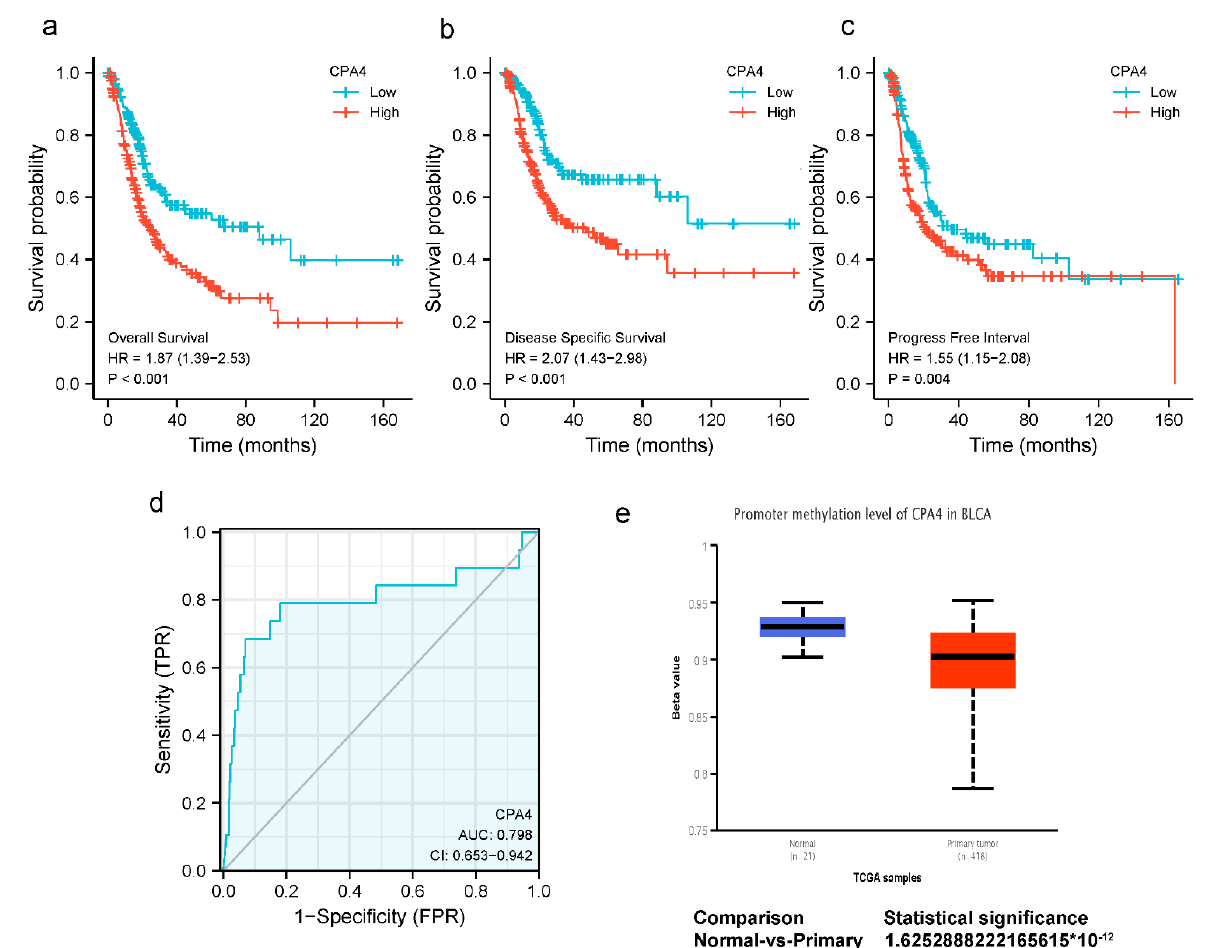
Figure 2. ( a – c ) Kaplan–Meier survival curves comparing high and low expressions of CPA4 in BLCA patients. ( a ) overall survival; ( b ) disease-specific survival; ( c ) progression-free interval; ( d ) ROC analysis of CPA4 indicates promising discrimination power between tumor and normal tissues; ( e ) the promoter methylation of CPA4 in tumor tissues ( n = 418) and normal tissues ( n = 21) from TCGA-BLCA data.